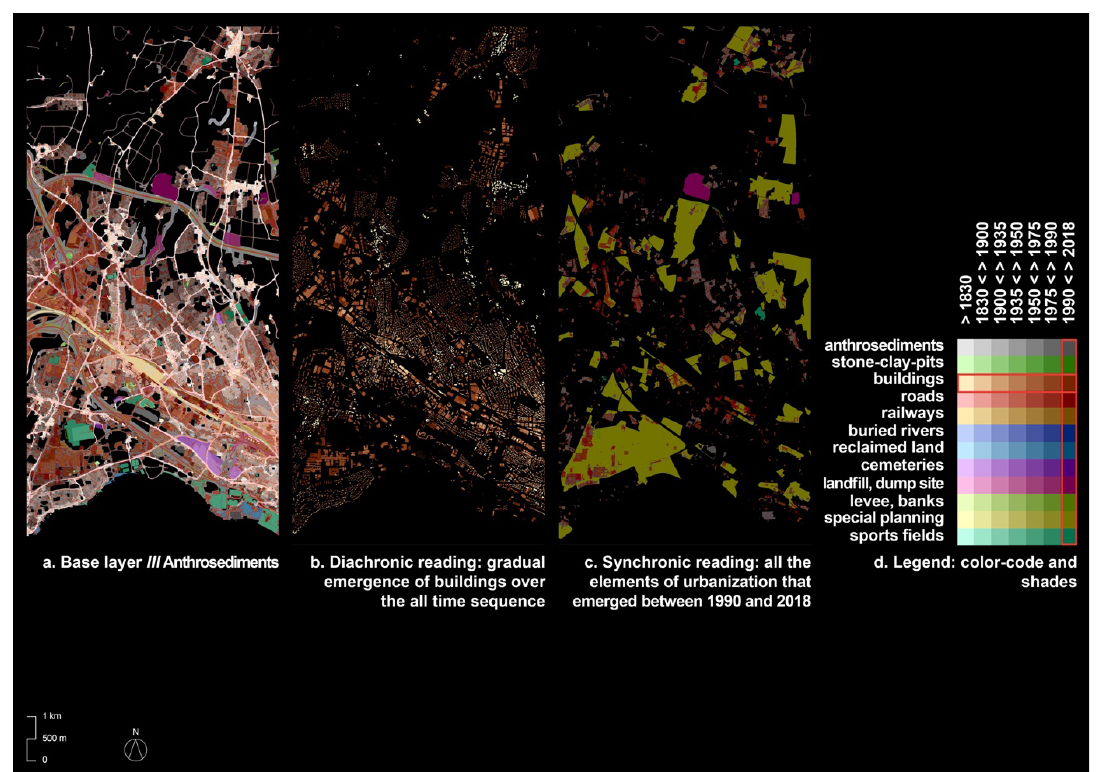
Figure 7. Base layer III. Source: Authors, based on geodata provided by Swisstopo and Canton de Vaud–Office de l’information sur le